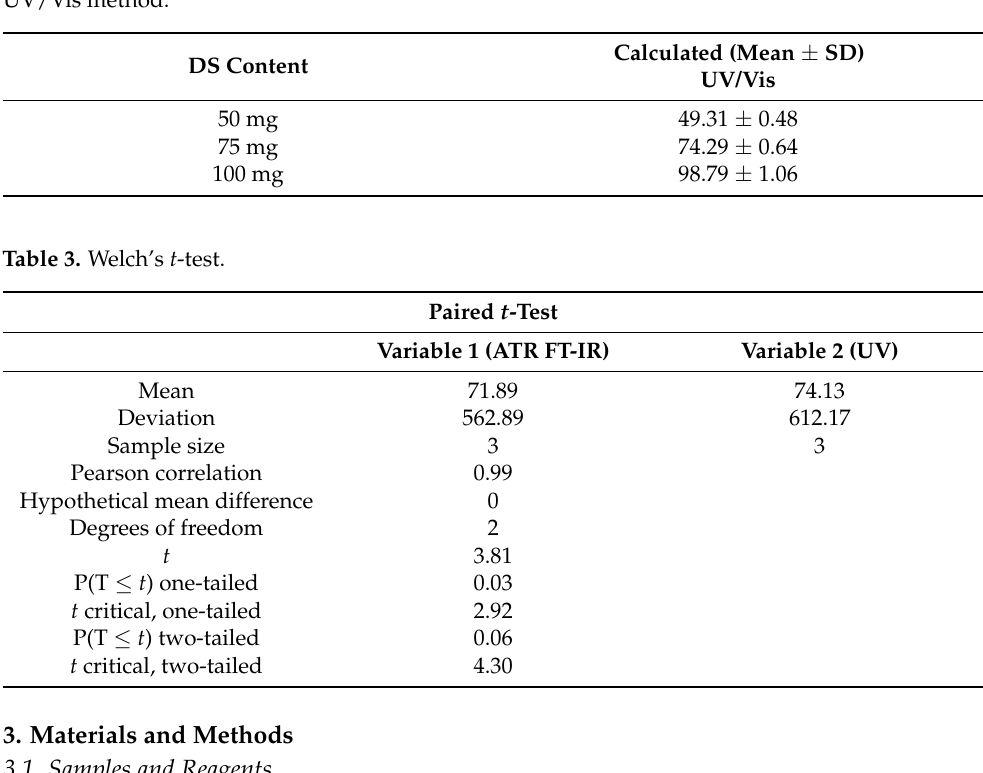
Table 2. The mean DS content values of the commercial tablets calculated by the reference UV/Vis method.